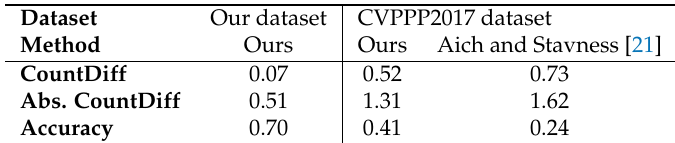
Table 1. Overall results of our method across all weed species in our dataset and against Aich and Stavness [21] on the CVPPP2017